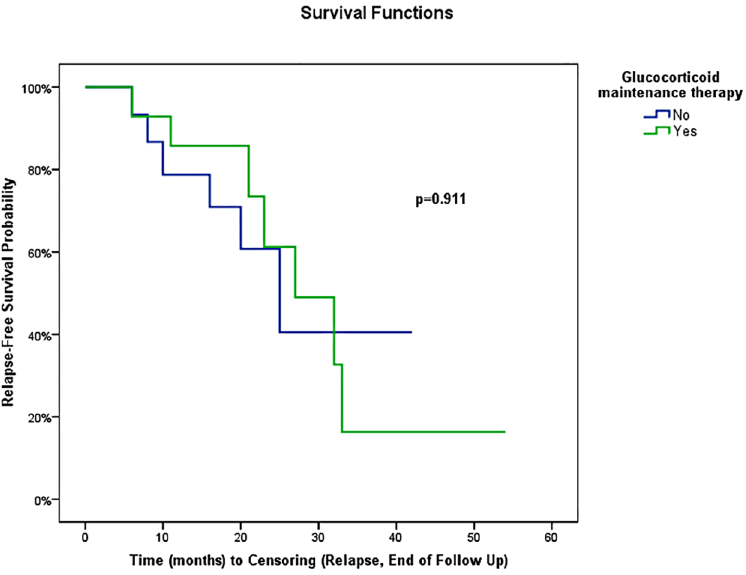
statistically associated with a longer relapse-free survival (mean relapse-free survival: 41.1 ±5.6 months, 95% CI: 30.2, 52.1) compared with patients who were not systematically retreated (mean relapse-free survival: 21.3 ±2.5 months, 95% CI: 16.3, 26.2) ( P = 0.02, Fig 4). In a bivari- ate model, IgG4-RD RI > 9 and systematic RTX maintenance retreatment were independently and statistically associated with relapse (IgG4-RD RI > 9 was predictive of relapse with